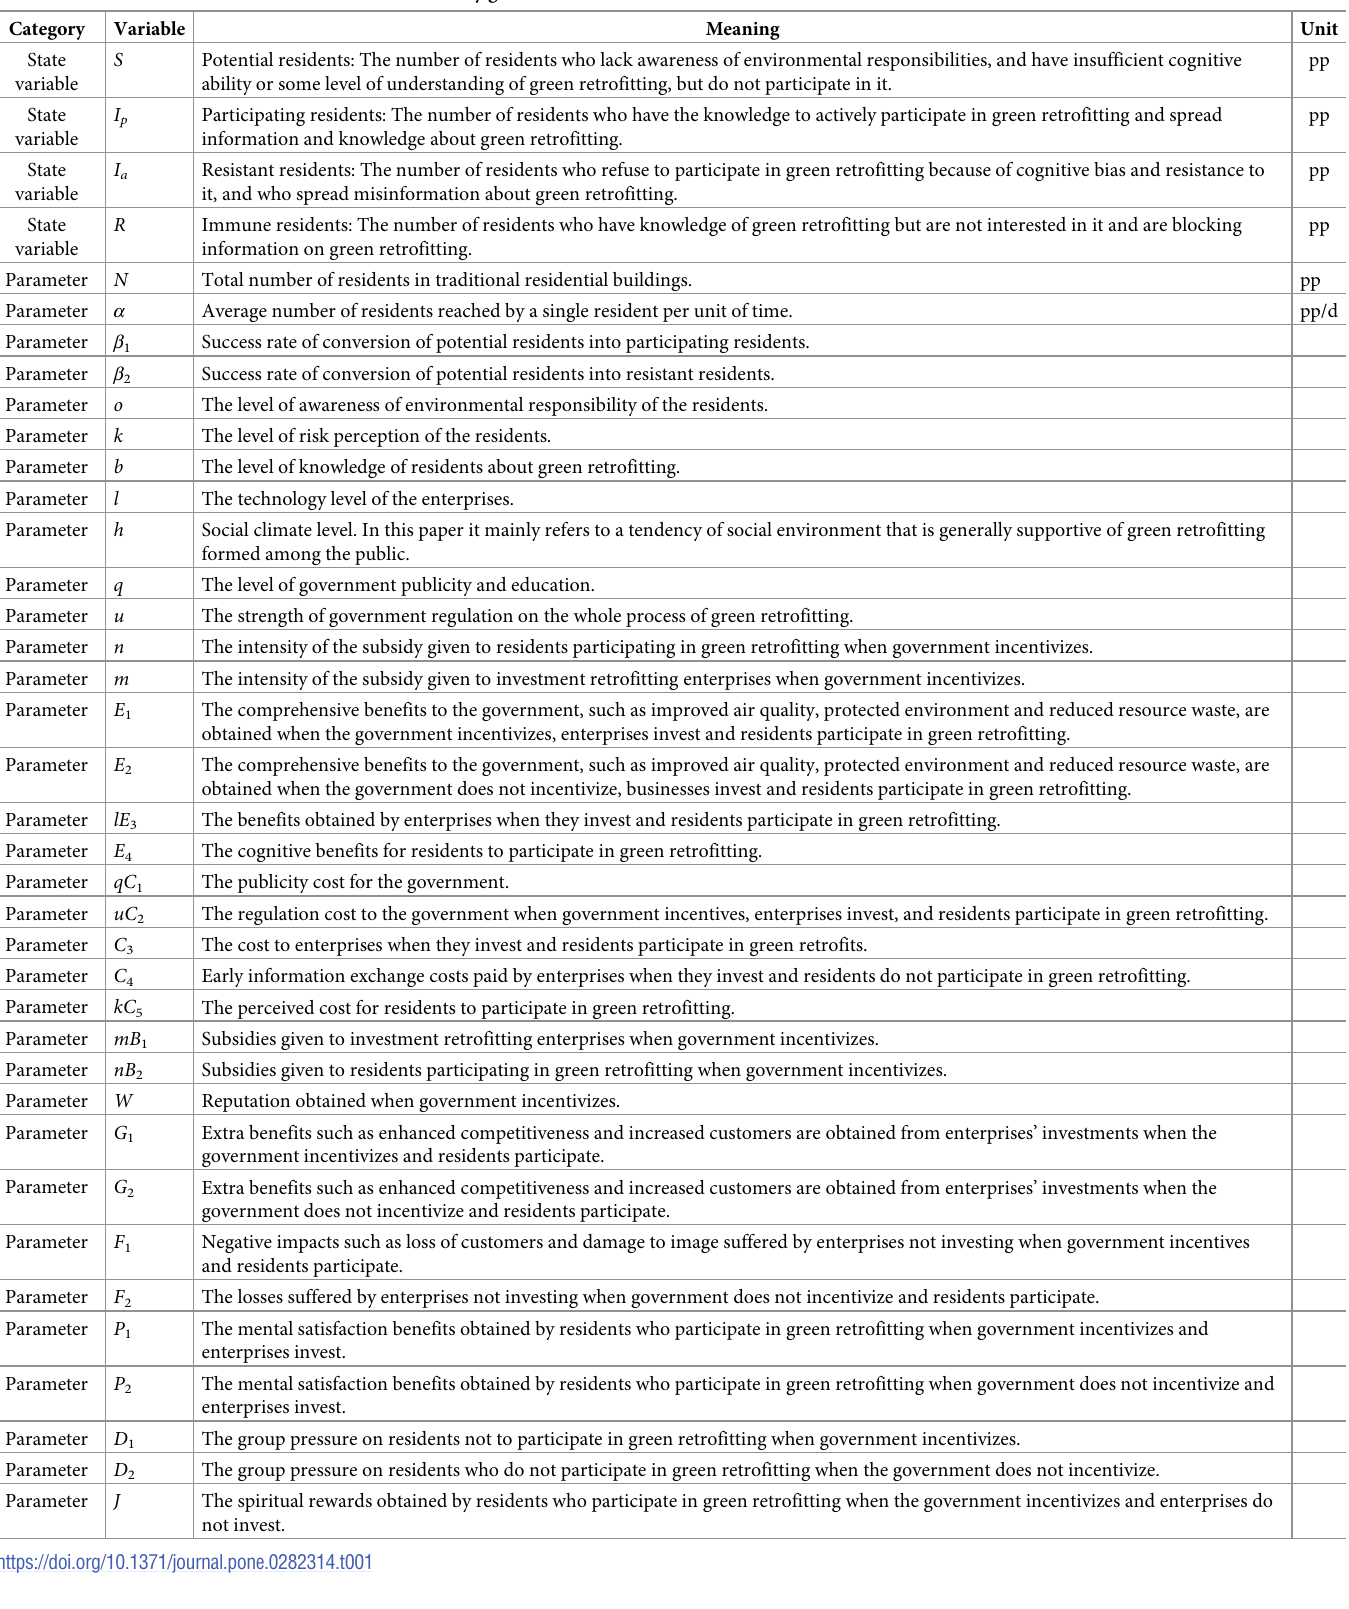
Table 1. Parameters of the dissemination and evolutionary game